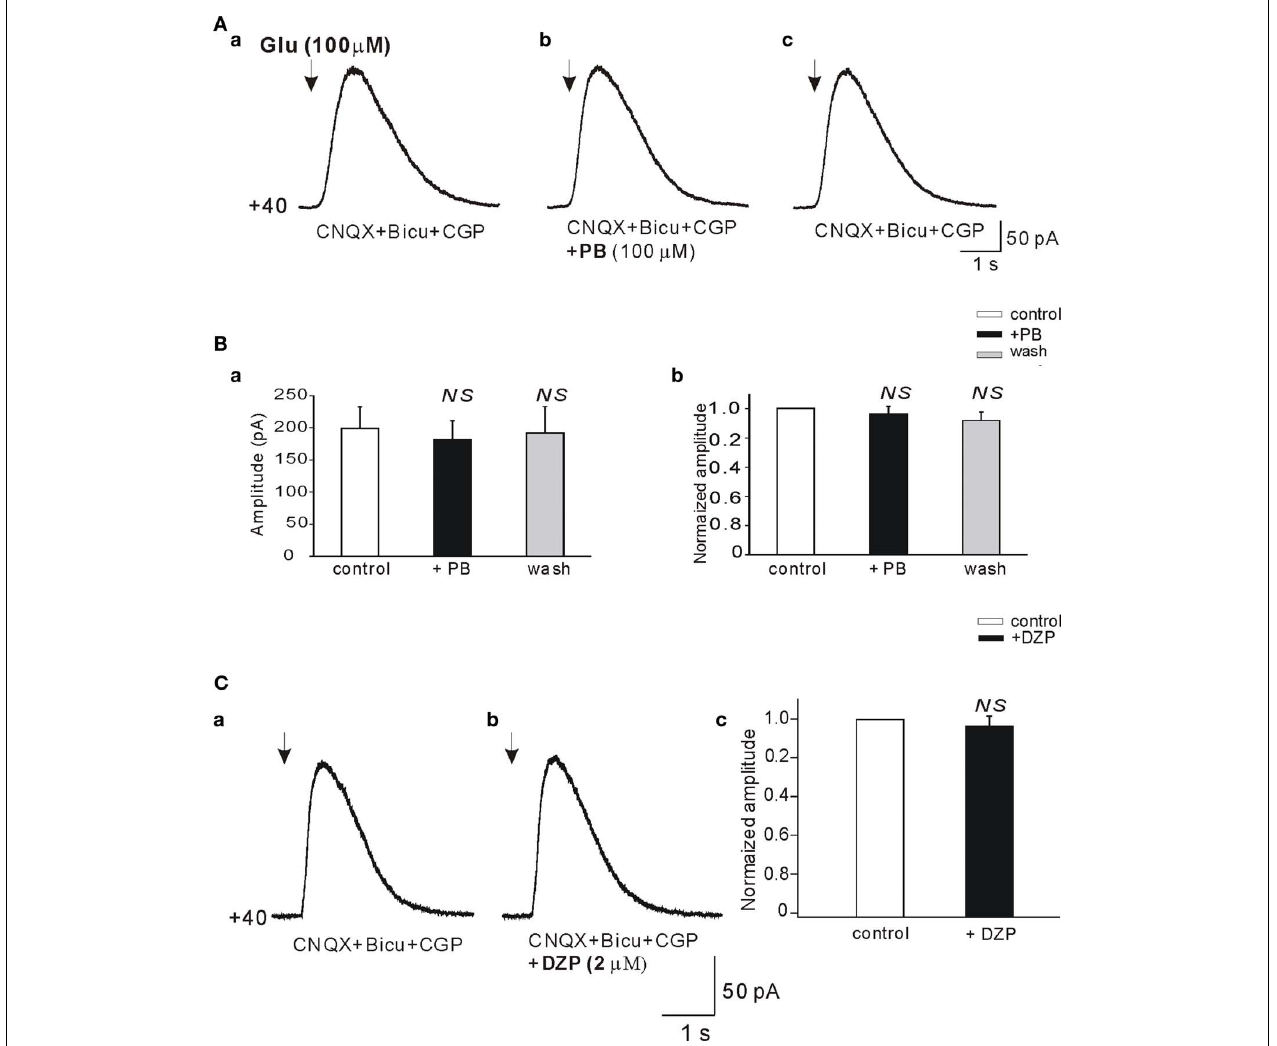
recorded from the same pyramidal cell. (Ba) Histogram of averaged ( n = 11) amplitudes of NMDA receptor mediated currents. (Bb) Histogram of averaged amplitudes normalized to control. Averaged NMDA receptor mediated currents before ( Ca ) and in the presence of DZP (Cb) . (Cc) Histogram of averaged ( n = 5) current amplitudes normalized to control. NS, not statistically